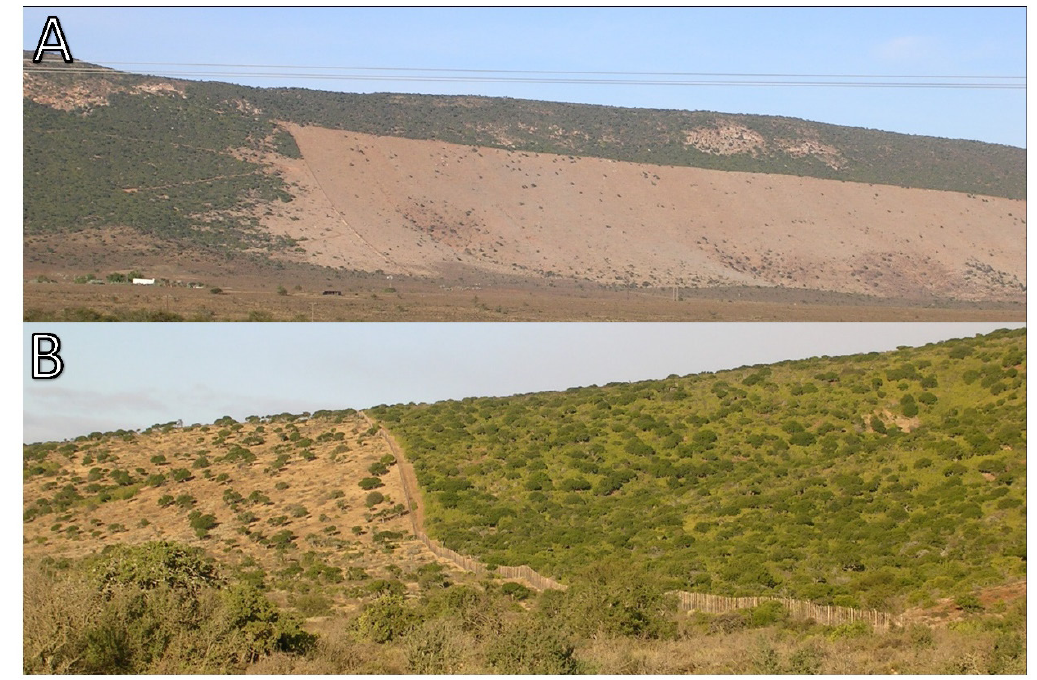
Figure 1. Fence-line contrasts of degraded versus intact subtropical thicket in the Eastern Cape, South Africa. ( A ) ~45 km NE of Steytlerville; ( B ) ~80 km SE of